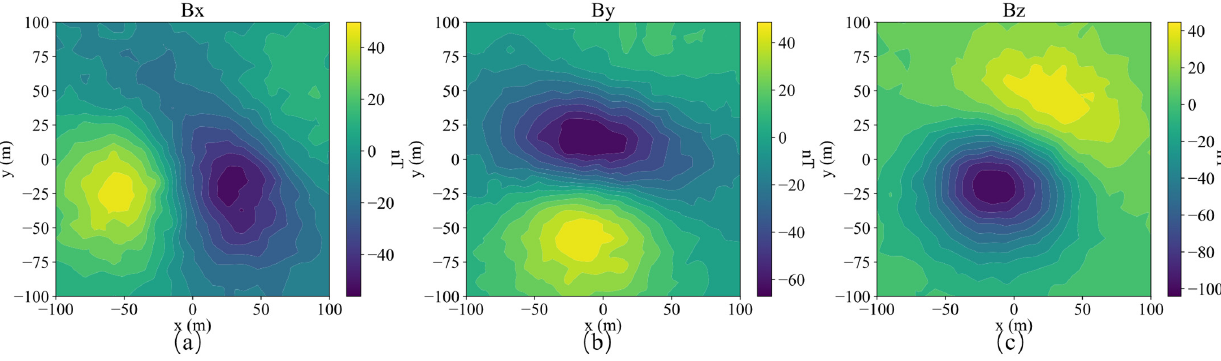
Figure 5. Three ‐ component observed data Bx ( a ), By ( b ) and Bz ( c ) of a single model.